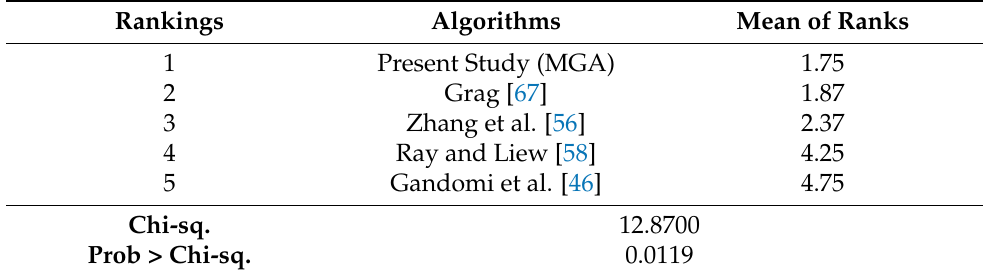
Table A10. Friedman statistical test results for the three-bar truss design problem.